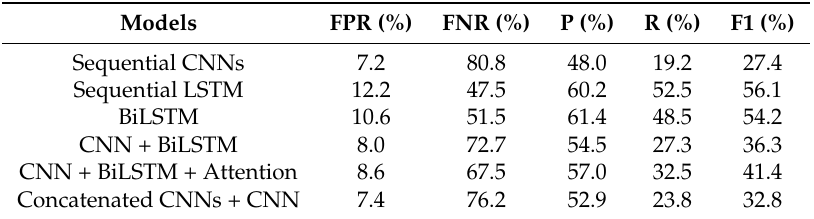
Table 3. Comparison of different representation learning models. CNN, convolutional neural networks. convolutional; BiLSTM, bidirectional long short-term memory; FPR, false positive rate; FNR, false negative rate; P, precision; R, recall; F1, f1-score. Models FPR